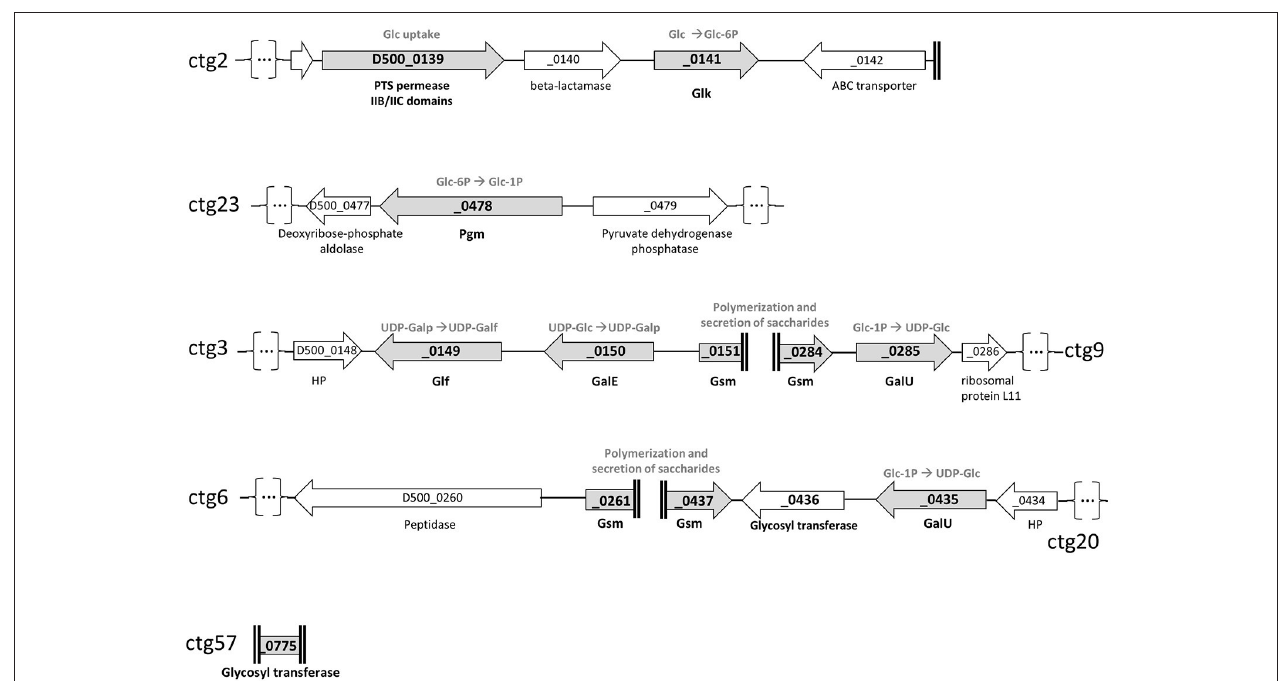
FIGURE 3 | Schematic representation of genome loci involved in polysaccharides biosynthetic pathways as predicted from the genome of M. feriruminatoris sp. nov. strain G5847 T . The coding sequences (CDS) are represented by arrows and designated by their locus tags. The name of the contigs (ctg) from which the CDS were retrieved are indicated on the right or the left of the figure. Ends of contigs are represented by double vertical bold lines and contig interruption, for representation purposes, by dots into brackets. Gray arrows correspond to CDS potentially involved in polysaccharide biosynthesis. These are a phosphotransferase system (PTS)-glucose permease and a glucokinase (Glk) for glucose (Glc) uptake and phosphorylation into glucose-6-phosphate; a phosphoglucomutase (Pgm) for isomerization of the glucose-6-phosphate into glucose-1-phosphate (Glc-1P); a glucose-1-phosphate uridylyltransferase (GalU) to transform Glc-1P to UDP-glucose; an UDP-glucose 4-epimerase (GalE) and an UDP-galactofuranose mutase (Glf) to successively transform the UDP-glucose into UDP-galactofuranose; a (or several) glycosyltransferase (GT) with synthase activity (Gsm; Glycan synthase of mollicutes) to build and export the final polysaccharide, suspected to be a polymer of galactofuranose (galactan). HP, Hypothetical Protein.